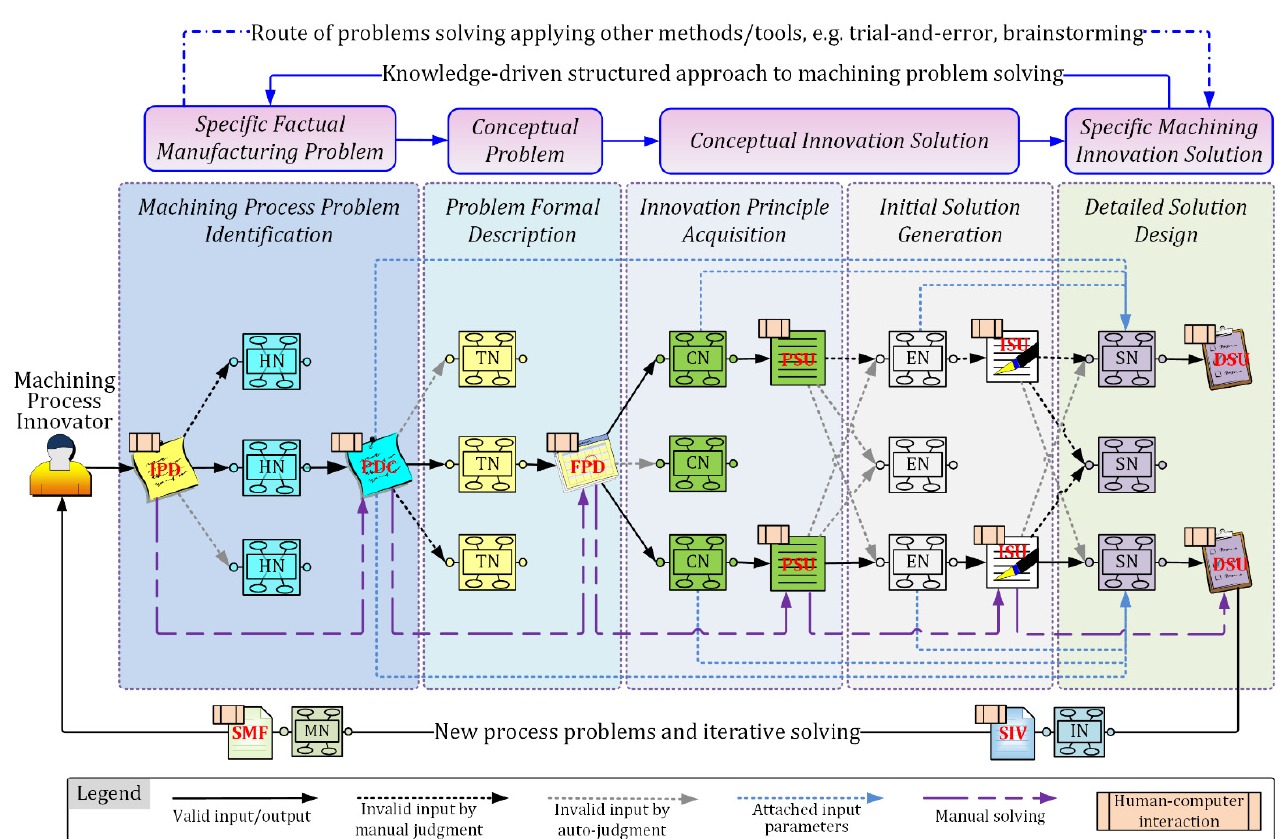
Figure 4. Structured problem-solving and innovation design procedure of machining process.